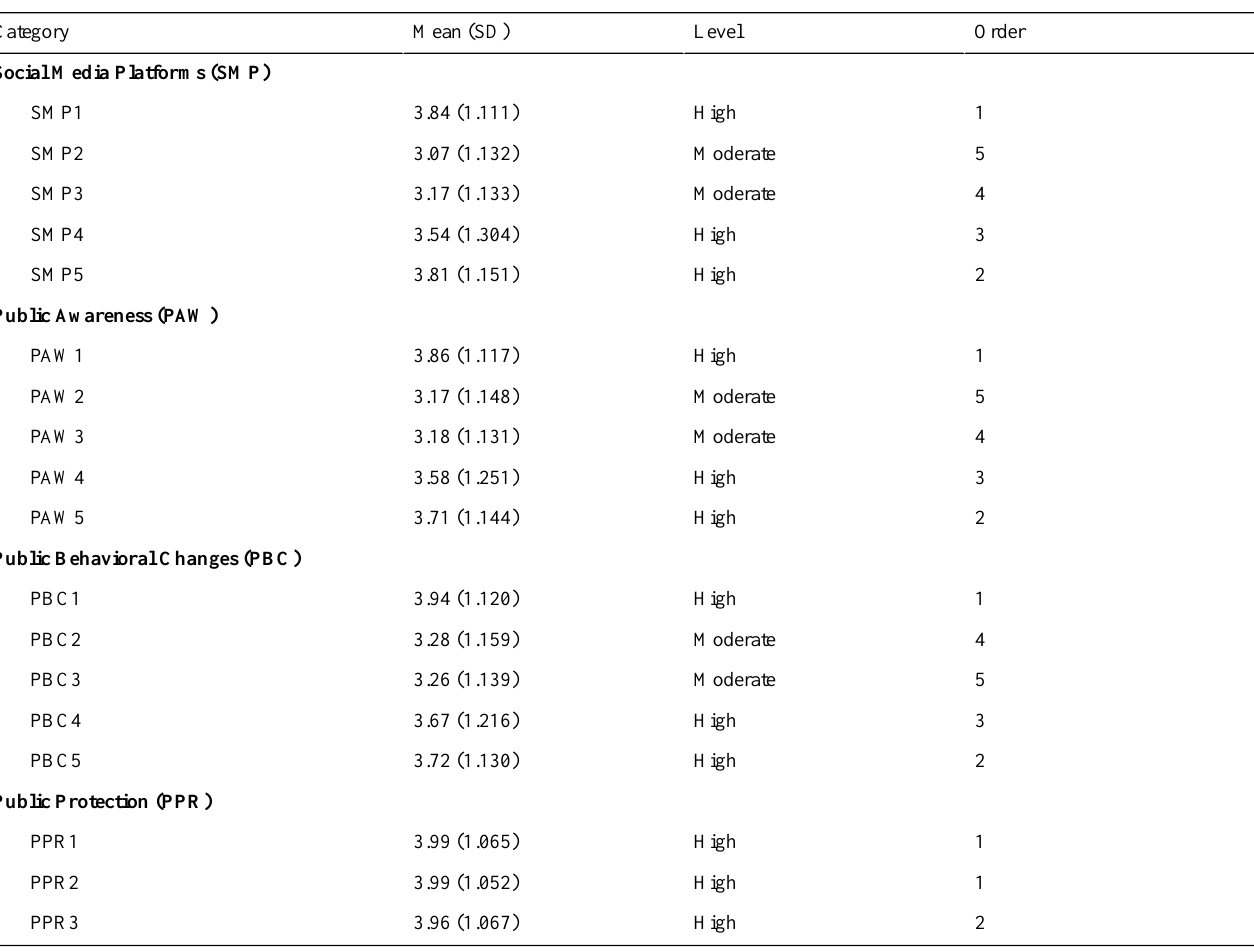
Table 3. Descriptive statistics of the research items and variables.